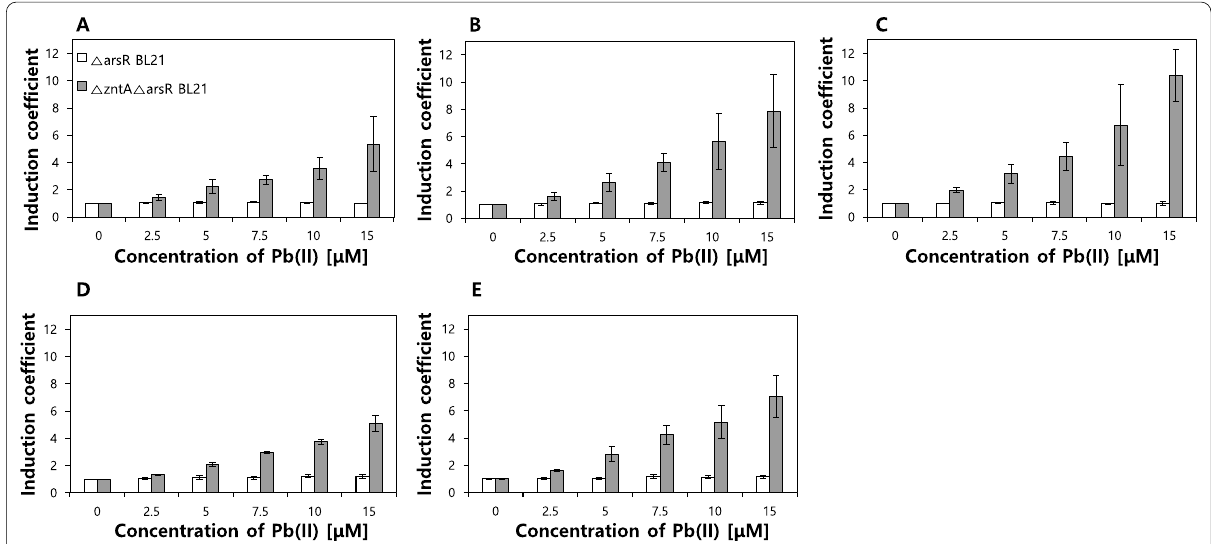
Fig. 4 Concentration-dependent responses of biosensors to Pb(II). The responses of biosensors using E. coli-arsR and E. coli-arsR/zntA as host cells to Pb(II) were compared upon regulatory proteins. The concentration of Pb(II) ranged from 0 to 15 µM. The responses are indicated as induction